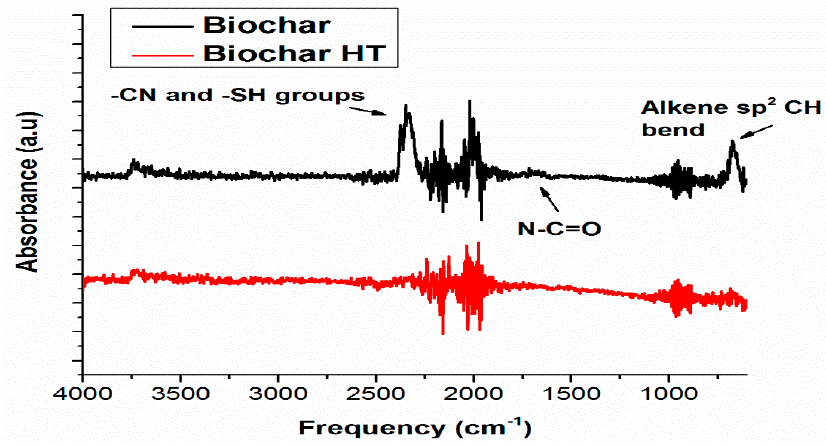
Figure 12. IR spectra of biochar and biochar HT.